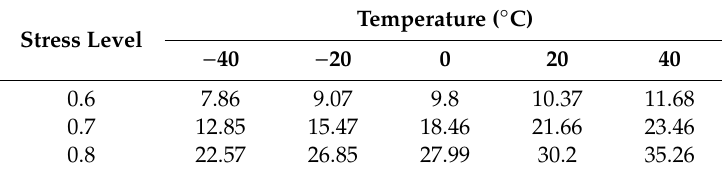
at di ff erent ambient temperatures and stress levels ( Ω · m). 0